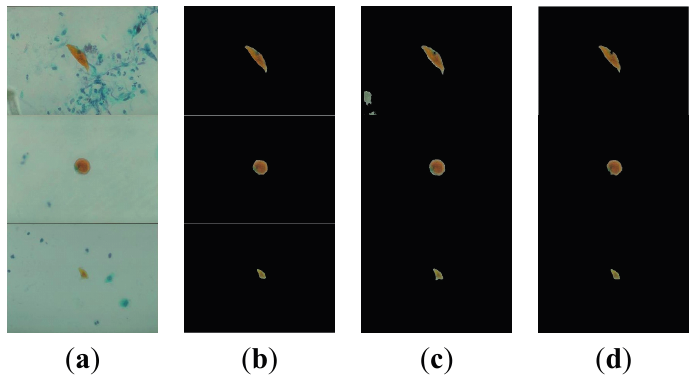
Figure 1. Samples of sputum cell extraction results. From left to right: ( a ) raw images; ( b ) ground truth data; ( c ) cell detection by using the Bayesian classifier with λ = 2; and ( d ) with λ =